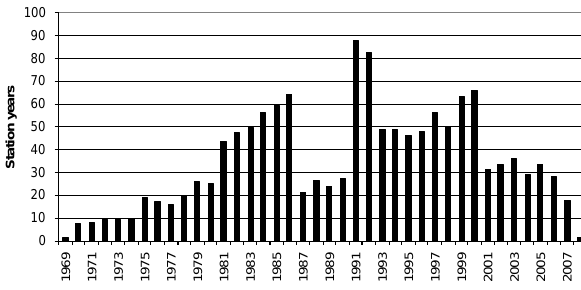
Fig. 1. Station years of precipitation data held in the NWRA archive for the period 1969–2008.